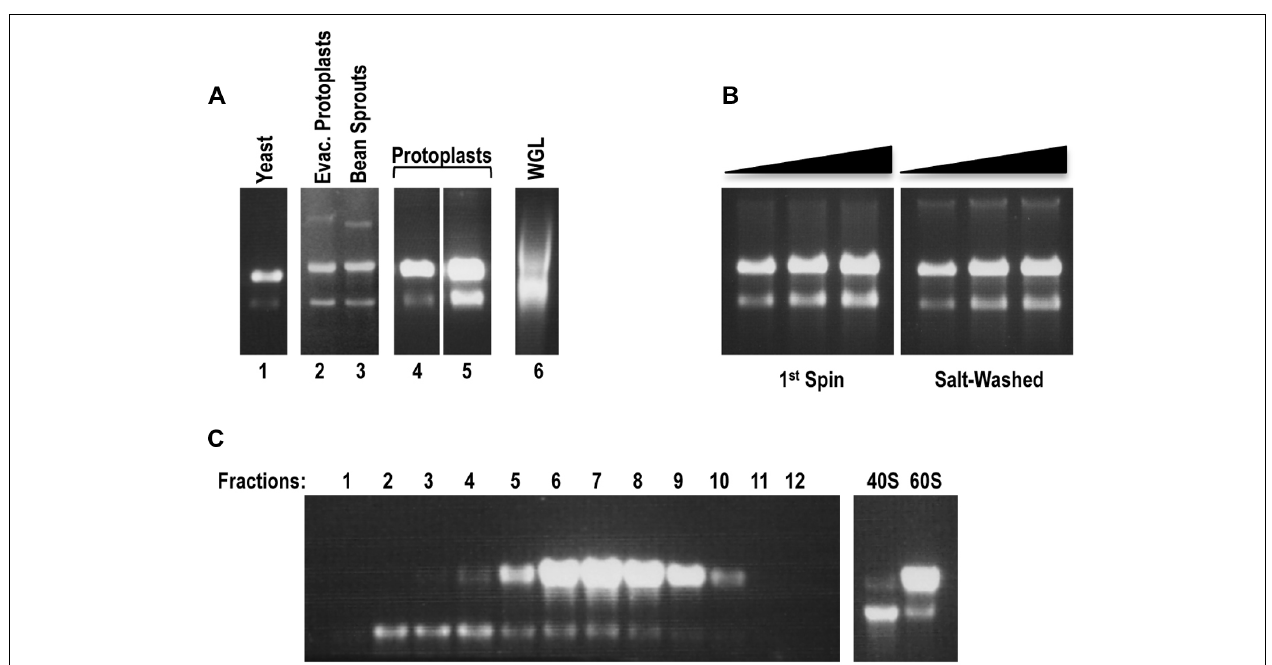
FIGURE 1 | Arabidopsis protoplasts serve as the optimal source for the preparation of plant ribosomes and their subunits. (A) In situ RNA gel electrophoresis analysis of small-scale ribosomal preparations (1st spin) from evacuolated Arabidopsis protoplast extracts (lane 2), bean sprouts (lane 3), Arabidopsis protoplasts (preparations 1 and 2, lanes 4 and 5).Yeast ribosomal preparation (lane 1) and aliquot of commercialWGL (Promega; lane 6) served as controls. Each preparation (1 ml, between 2.5 and 5 pmol of ribosomes) was resuspended in an equal volume of 100% formamide and the mixture directly loaded onto a 1.2%, 0.5 × TBE agarose gel. rRNA was detected by staining gel with ethidium bromide. Note that although 80S ribosomes were loaded, the ribosome subunits disengage in the gel and thus the large and small rRNAs become separated. (B) In situ RNA gel electrophoresis analysis